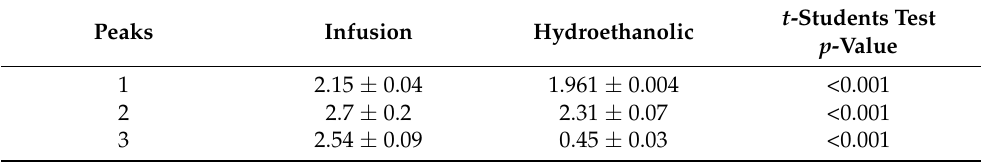
Table 4. Quantification (mg g − 1 of extract) of the phenolic compounds present in the infusion preparations and hydroethanolic extracts of L. canadensis (mean ± SD, n = 3 ). Peaks Infusion